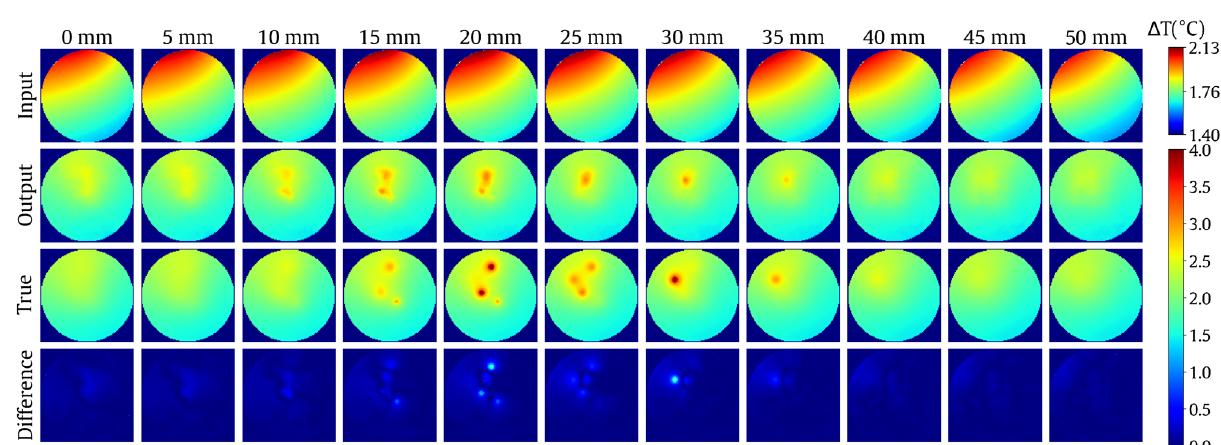
Figure 9. Visualization of the best-case reconstruction ( NMSE = 0.004 ) in the multiple-heat-source experiment with a five-block CNN. Top to bottom: backprojection slices, final tomographic reconstruction slices, ground-truth slices, the difference between the reconstruction and ground truth (reconstruction error). The location (height) of each slice is given above the column. For volumetric visualization of the reconstruction outcome, see Supplementary Video